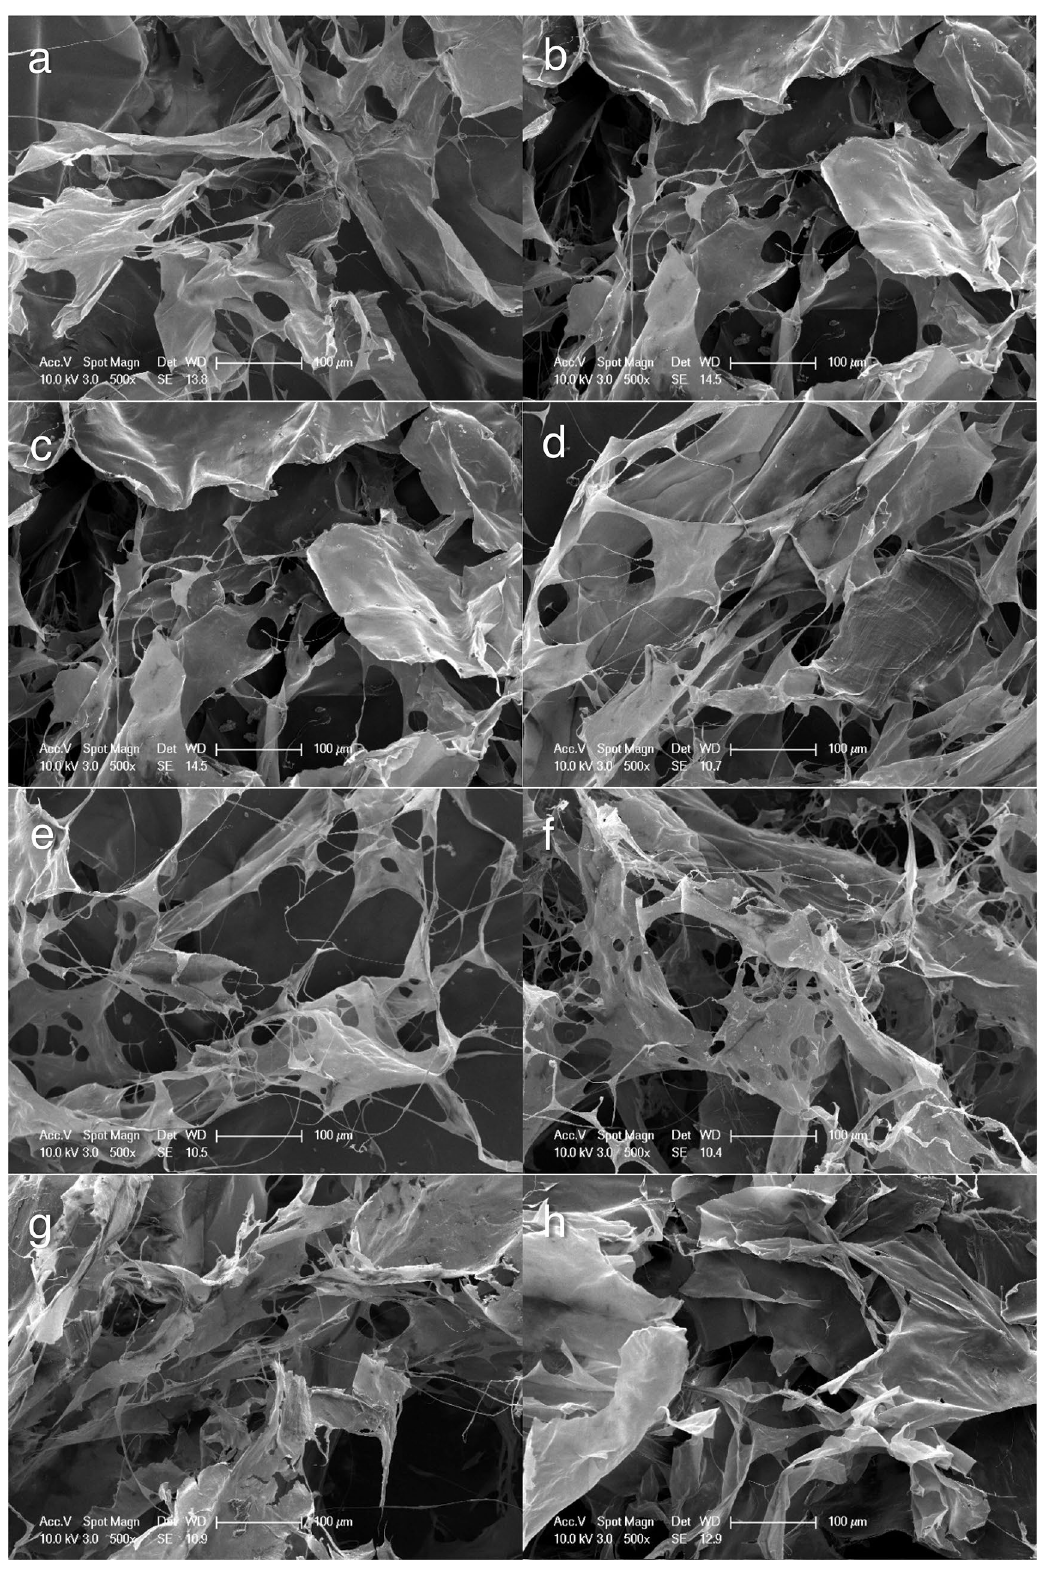
Figure 10. Scanning electron microscopy images of ( a ) non-modified beta-chitin patch, ( b ) Chi/F127, ( c ) Chi/ PEO, ( d ) Chi/5%Ca, ( e ) Chi/10%Ca, ( f ) Chi/20%Ca, ( g ) Chi/Thick and ( h )